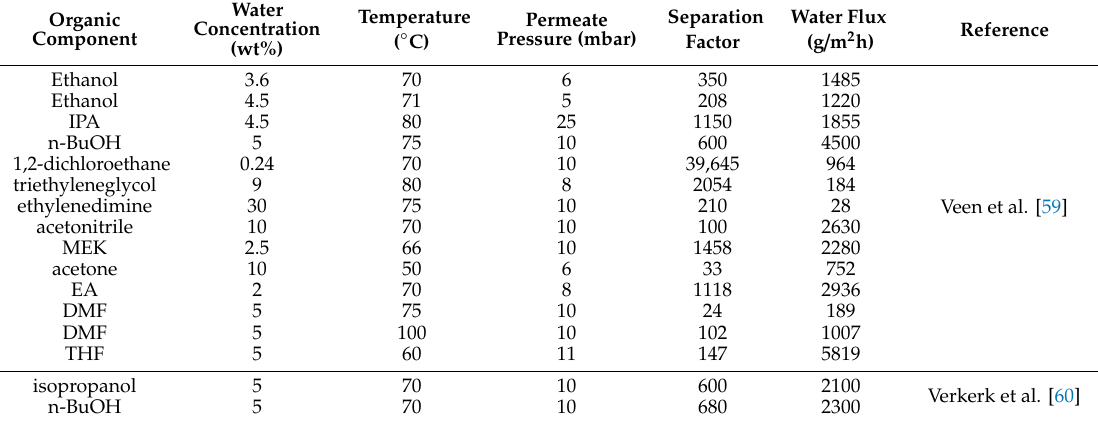
Table 2. Pervaporation performance for various solvents in their aqueous solutions, separation achieved using the commercial silica membrane, ECN (Petten, The Netherlands). Adapted from [59,60] with permission from Copyright (2001), Elsevier Science B.V.